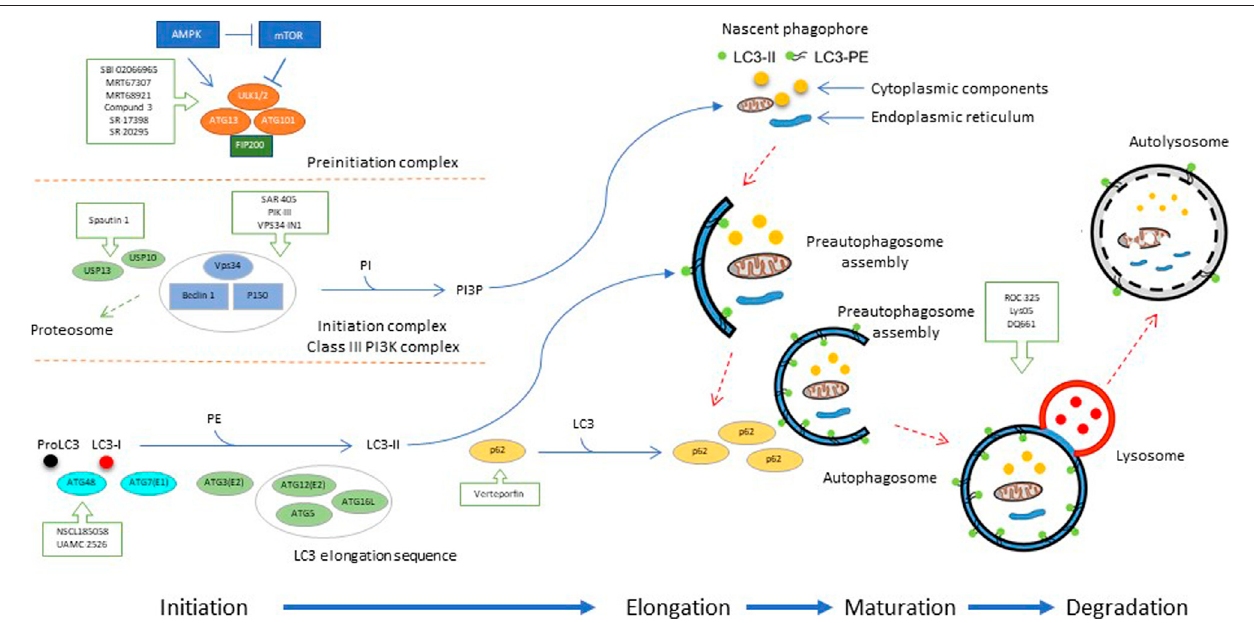
FIGURE 2 | Modulation of multiple stages of autophagy process by small molecules. As illustrated in the schema, autophagy is a process where cells recycle proteinsandotheressentialsubstratesandmacromoleculesincludingwholeorganellessuchasmitochondriabyforminganautophagosome.Autophagosomescon fi ne and distribute their cargofor ahighly regulated autophagy process which involves thefusionofautophagosomeswithlysosomes.Therefore, each ofthe keycomplexes formed throughout the autophagy process involving preinitiation, initiation, elongation, maturation and degradation steps provide opportunities for therapeutic interventions by the small molecules that can modulate autophagic pathways. Under nutrient deprivation, mTOR is inactivated and AMPK is activated leading to phosphorylationofnegativeandpositiveregulatorysitesonULK1/2withinthepreinitiationcomplexwhichsubsequentlyactivatestheinitiationcomplexortheclassIIIPI- IIIK complex via phosphorylation of VPS34 and Beclin-1. The initiation complex involves the production of PI3P from the precursor PI needed for nucleation of the isolation of the autophagosome initiation membrane. Cellular concentrations of the initiation complex are regulated by a ubiquitination cascade which is regulated by USP10 and USP13 deubiquitination peptidases. Expansion of nascent precursor vesicles depends on the autophagosome LC3 protein which then conjugates with PE forming LC3-II protein which is derived from the LC3 elongation sequence of modifying enzymes. LC3-I is generated by proteolytic cleavage of proLC3 by the ATG4B. LC3-I is subsequently conjugated with lipids by a series of conjugating enzymes to form the LC3-II which then forms a stable complex with the membranes of autophagosomes. The p62 scaffold protein also plays an important role in the traf fi cking of proteins to the autophagosome by stably binding to the LC3-II protein. p62 also plays a role in apoptosis pathways. Abbreviations: mTOR, mammalian target of rapamycin; AMPK, 5 ′ -AMP-activated protein kinase; ULK1/2, Unc-51-like autophagy activating kinase 1/2; VPS34, vacuolar protein sorting protein 34; PI3P, phosphatidylinositol-3-phosphate, PI: phosphatidylinositol, USP10 and